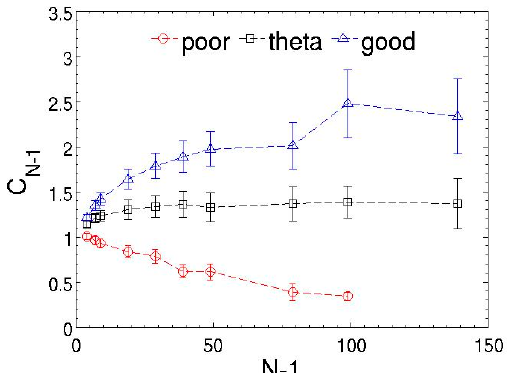
Figure 5. Characteristic ratio of the modeled chains as a function of chain length for different solvent quality. Poor, theta, and good solvents refer to the systems with polymer–solvent attraction parameter A ps = − 36, − 38.5, and − 40, respectively. The lines are only guides to the eyes. The error bars represent the standard deviations of the ensemble averages.